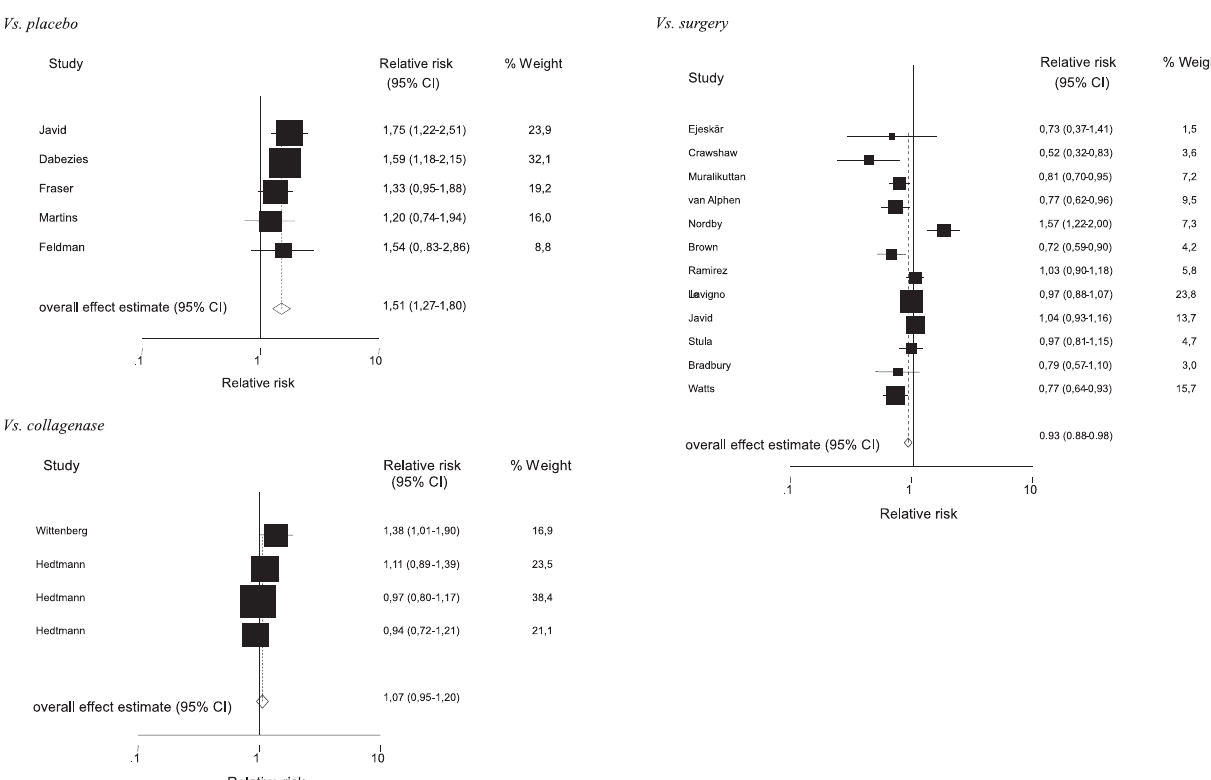
Figure 2 - Forest plots with results of individual studies and summary effect estimates for chemonucleolysis versus placebo, collagenase, and surgery. Table 3 - Clinical trials of chemonucleolysis versus surgery Trial Publication